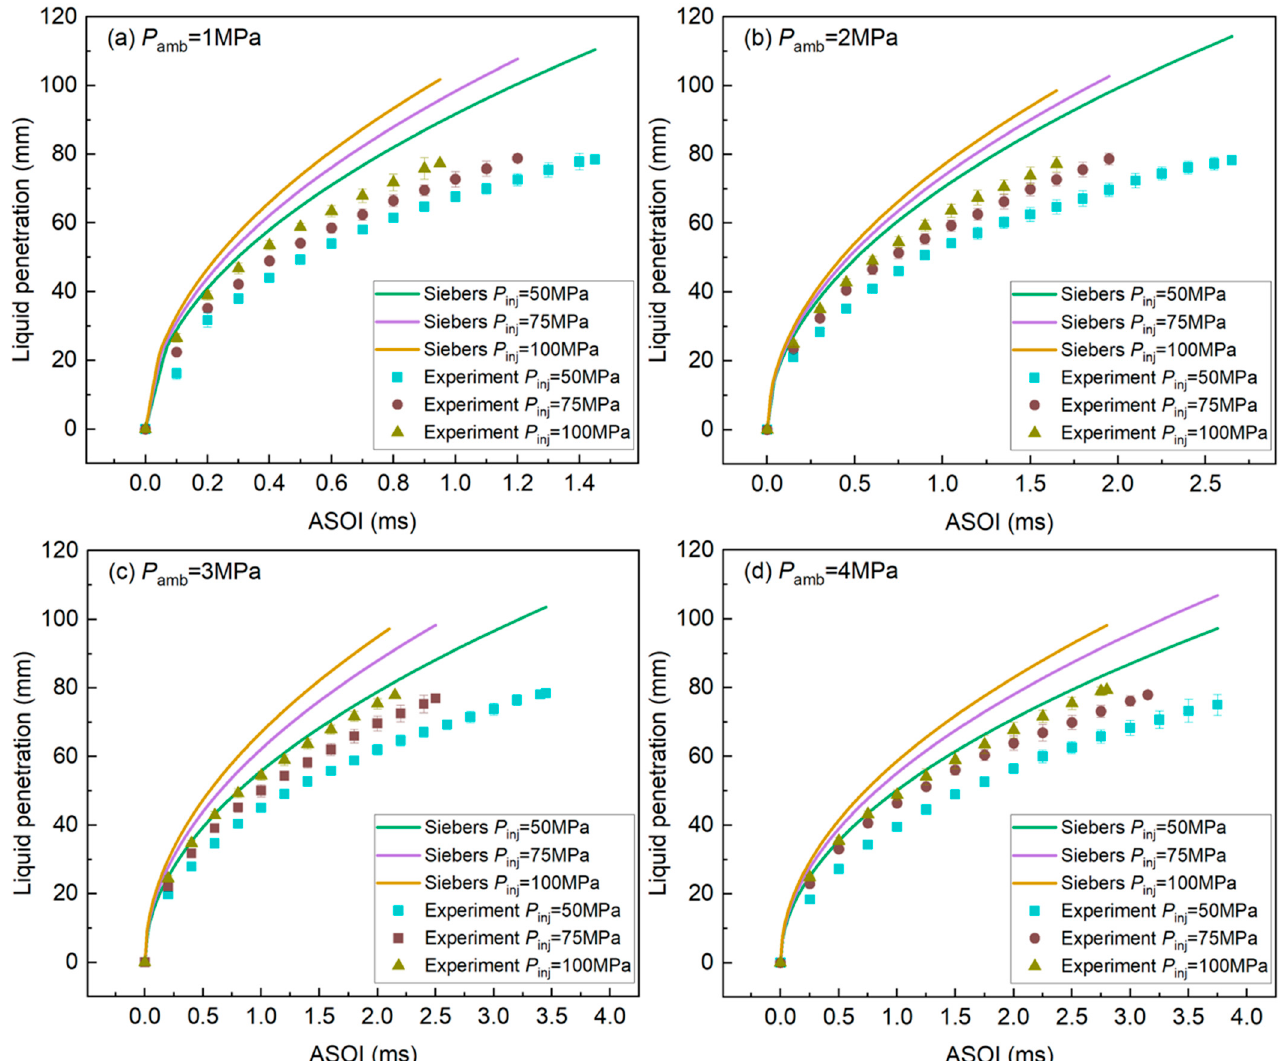
Figure 4. Liquid penetration in the Siebers model prediction and experiments; fuel: liquid ammo- nia; ( a ) P amb = 1 MPa, ( b ) P amb = 2 MPa, ( c ) P amb = 3 MPa; ( d ) P amb = 4 MPa. ( a ) P amb = 1 MPa, ( b ) P amb = 2 MPa, ( c ) P amb = 3 MPa; ( d ) P amb = 4